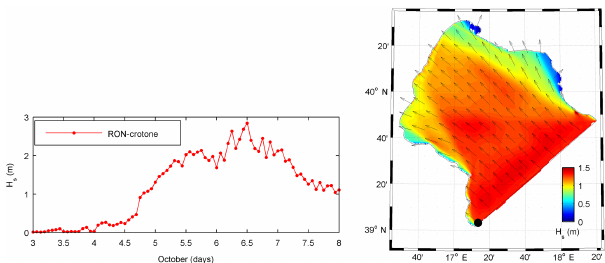
Figure 6. Numerical results from the TEL2D + TOM run for the Gulf of Taranto: significant wave height from Crotone buoy (black circle in the right panel) imposed on the offshore boundary (left panel), and snapshot (right panel) of wave propagation on 6 October 2014 at 14:00 (color map of the significant height, H s , and arrows of the mean direction).